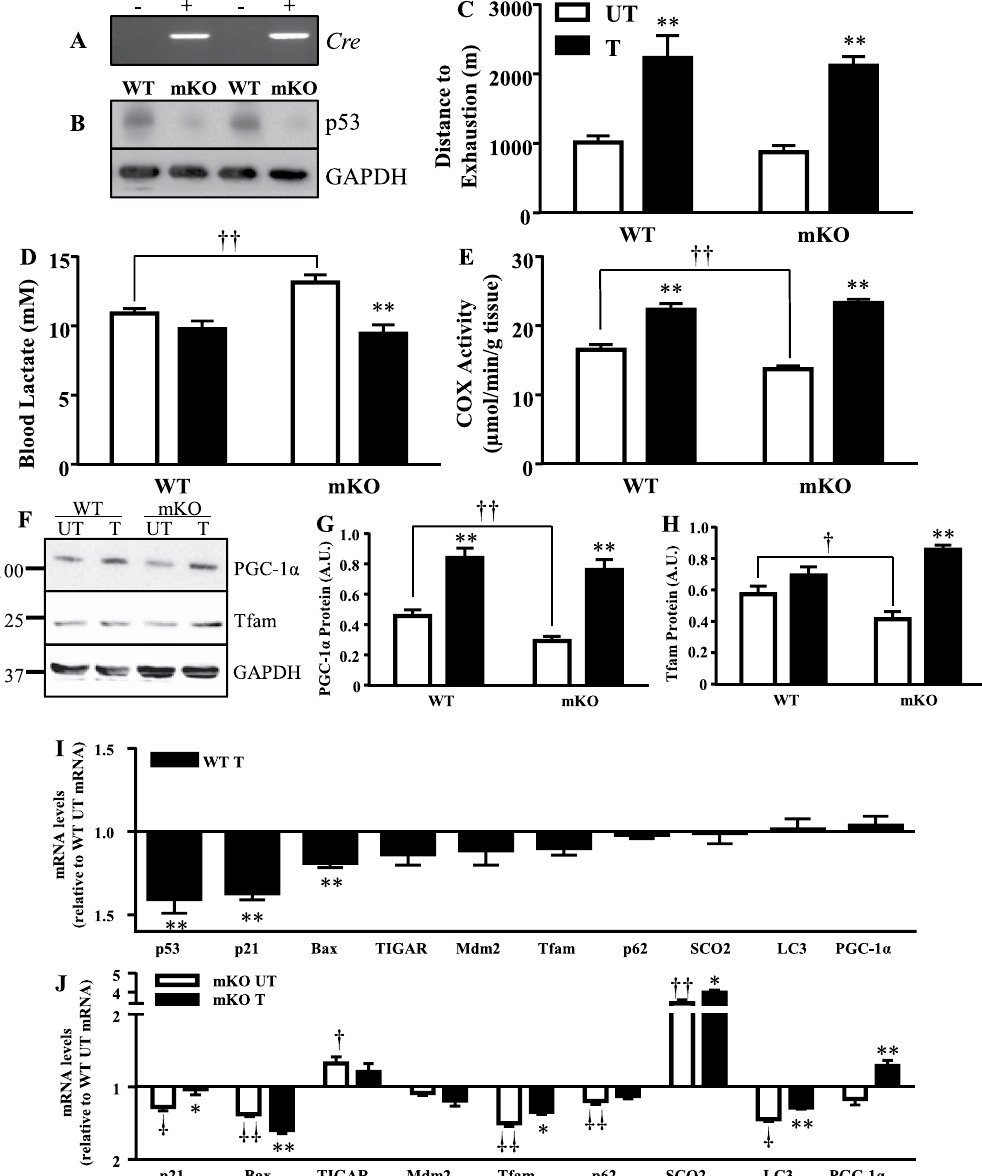
Figure 2. Mitochondrial content, exercise capacity, and lactate handling improves with exercise training, while gene expression is altered. The deletion of p53 in skeletal muscle of MS mKO mice was examined through ( A ) genotype against the Cre transcript, and ( B ) total p53 protein in whole muscle. Following the 6-week training/ sedentary protocol, mice were subjected to an exhaustive bout of exercise to determine training-induced adaptations by measuring ( C ) distance to exhaustion (n = 6–8/group); ** p ≤ 0.01, UT vs. T, 2-way ANOVA, and ( D ) final lactate production levels (n = 6–8/group), ** p ≤ 0.01, UT vs. T; †† p ≤ 0.01, UT WT vs. mKO, Student’s t-test. Mitochondrial biogenesis with training was measured through the assessment of ( E ) COX enzyme activity, a marker of mitochondrial content (n = 6–8/group); ** p ≤ 0.01, UT vs. T, 2-way ANOVA; †† p ≤ 0.01, UT WT vs. mKO, Student’s t-test, and ( F ) mitochondrial biogenesis markers ( G ) PGC-1 α protein (n = 5–8/ group); ** p ≤ 0.01, UT vs. T, 2-way ANOVA; †† p ≤ 0.01, UT WT vs. mKO, Student’s t-test, and ( H ) Tfam protein (n = 6–7/group); ** p ≤ 0.01, UT vs. T, 2-way ANOVA; † p ≤ 0.05, UT WT vs. mKO, Student’s t-test. ( I ) The effect of training on mRNA transcripts of signaling pathways including cellular senescence ( p21 ), apoptosis ( Bax ), metabolism ( TIGAR ), autophagy ( p62 , LC3 ), oxidative phosphorylation ( SCO2 ), mitochondrial biogenesis ( PGC-1 α , Tfam ) and p53 and its negative regulator Mdm2 , in WT mice. Data are presented as fold change over WT control levels (n = 8–10/group); ** p ≤ 0.01, UT vs. T, Student’s t-test. ( J ) Effect of the absence of p53, and training on mRNA transcripts of signaling pathways. Data presented as fold change of mKO over WT untrained levels and as mKO trained over untrained levels (n = 7–11/group); * p ≤ 0.05, ** p ≤ 0.01, mKO UT vs. T; † p ≤ 0.05, †† p ≤ 0.01, UT WT vs. mKO, Student’s t-test. Data are presented as mean ±